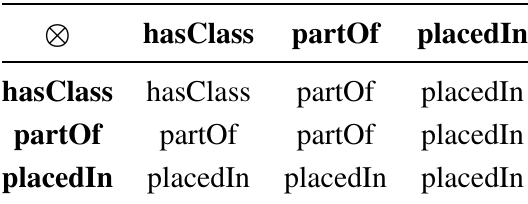
Table 2. Composition of